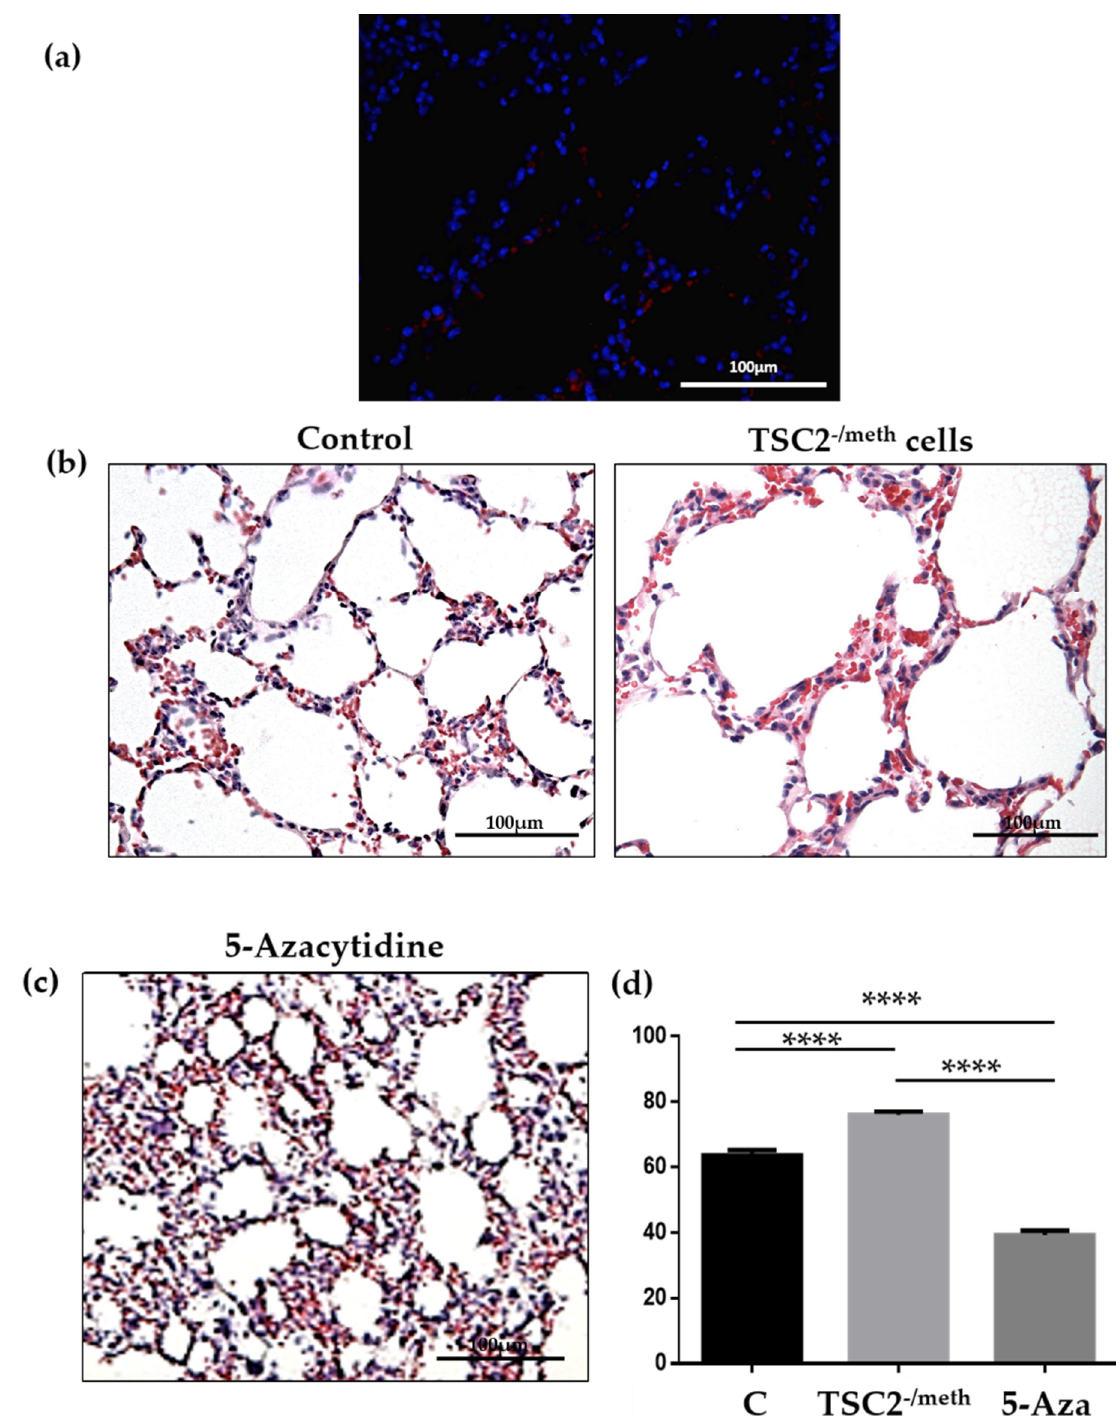
Figure 6. ( a ) Red fluorescent PKH26-positive cells were detected in lung parenchyma 60 days after the injection. Nuclei were stained with DAPI. ( b ) Representative hematoxylin–eosin staining on lung section of control mice (left) and mice injected with TSC2 -/meth cells (right). ( c ) Representative hematoxylin–eosin staining on lung section of mice treated with 5-azacytidine. Scale bar: 100 µm. ( d ) Quantification of the fraction of the hair-exchanging parenchyma ( A A (ae/lu)) in n = 3 mice per condition, expressed as a percentage (C: control; TSC2 -/meth : mice injected with tuberin-null cells; 5-Aza: mice injected with tuberin-null cells and treated with 5-azacytidine for 4 days, 60 days after cells injection). ANOVA with Tukey’s test. **** p < 0.0001; results are shown as mean ± SEM.